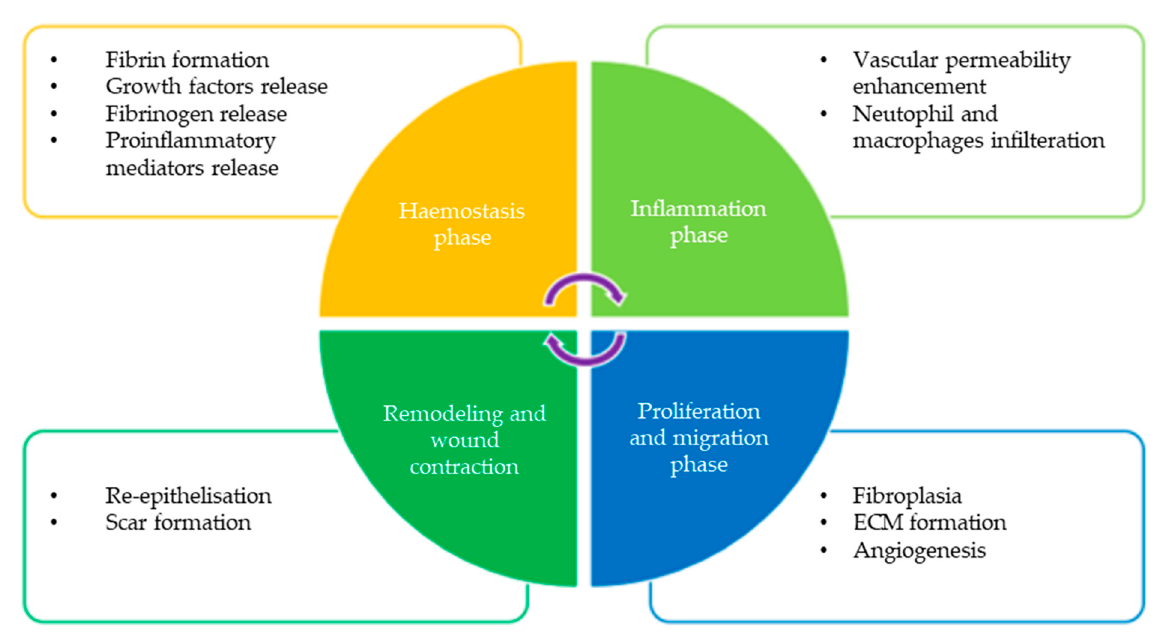
Figure 1. Wound healing process and the mediators/cells involved in the wound healing cascade. Reproduced from [8] with permission from Elsevier.